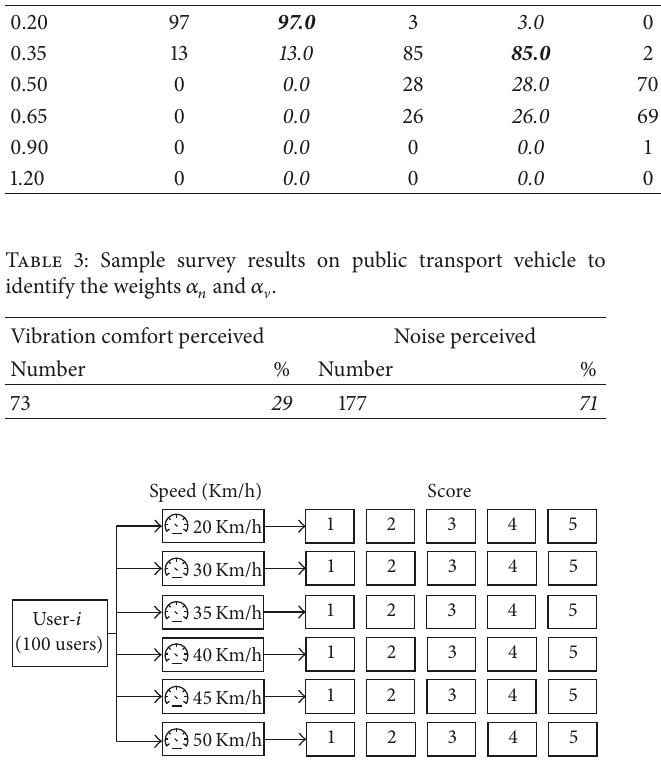
Figure 6: Preliminary sample survey flow chart to detect the perceived vibration level.